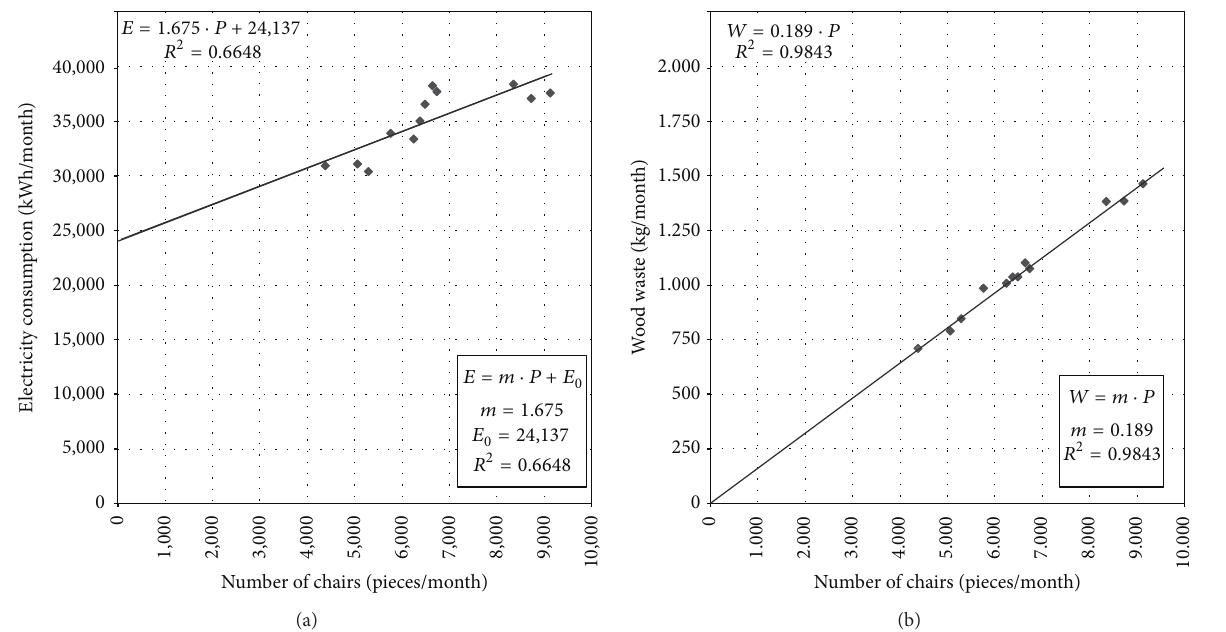
Figure 3: Dependence of (a) energy consumption (b) generated waste on production volume.